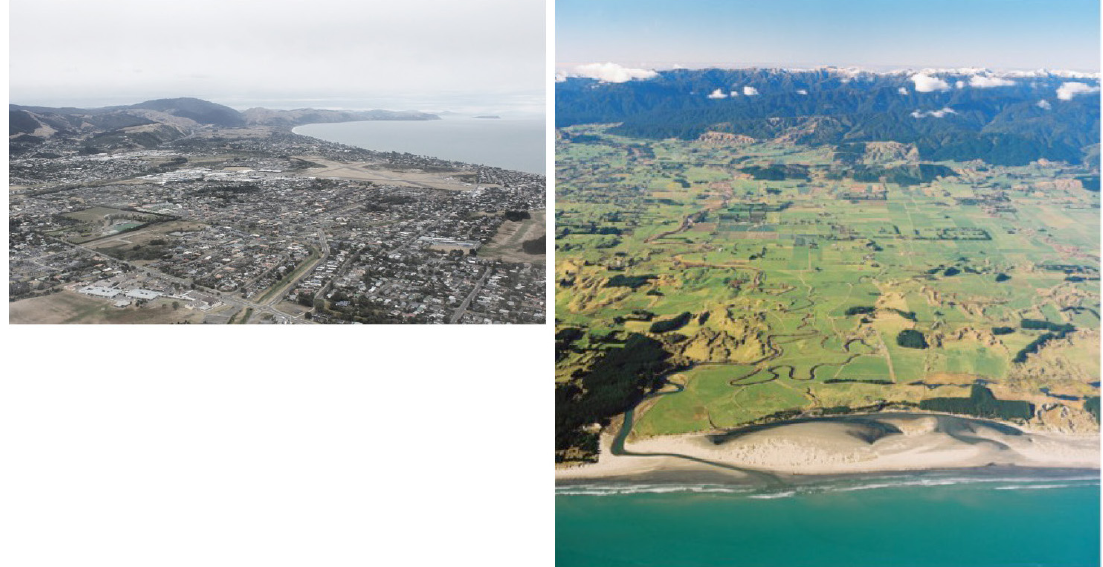
Figure 2. Aerial photos of existing settlement near Paraparaumu (left) and farmland north of Otaki (right) Source: Ben Allnatt; Huhana Smith .